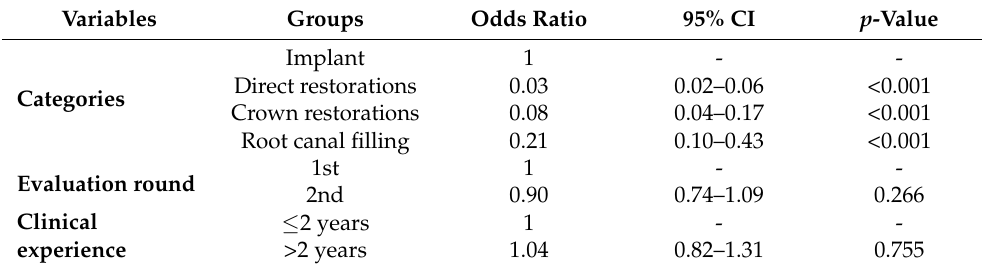
Table 6. Odds ratios with corresponding 95% confidence intervals (CI) and p -values were computed according to the logistic regression model. Bold numbers illustrate a significant